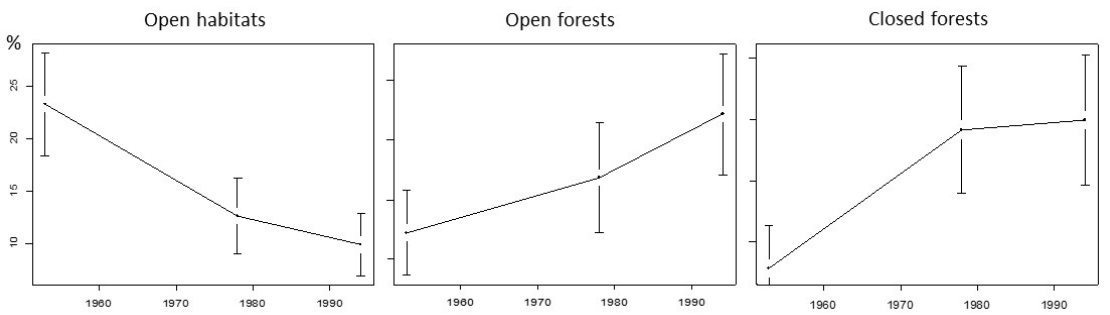
Figure A2. Proportions of open habitats and forest habitats (as percentages of the study area) at three dates from 1953 to 1994. From Sébastien Tomas (unpublished results).